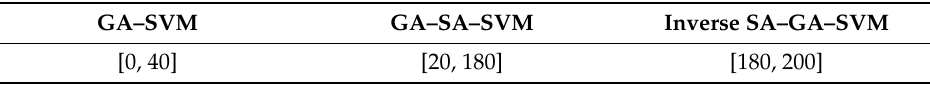
Table 4. Generation interval of three